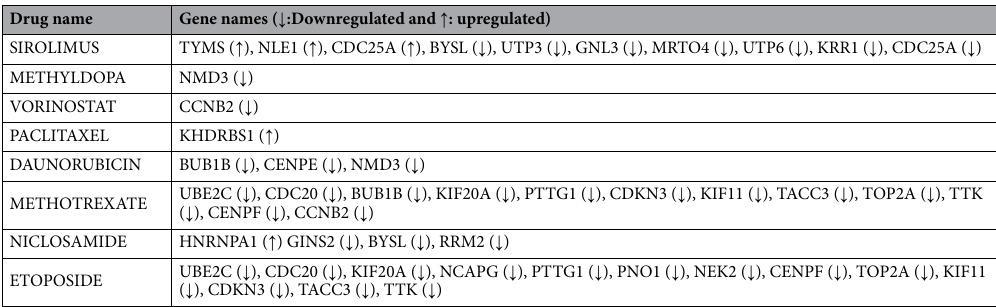
Table 6. The validated candidate drugs by CMAP